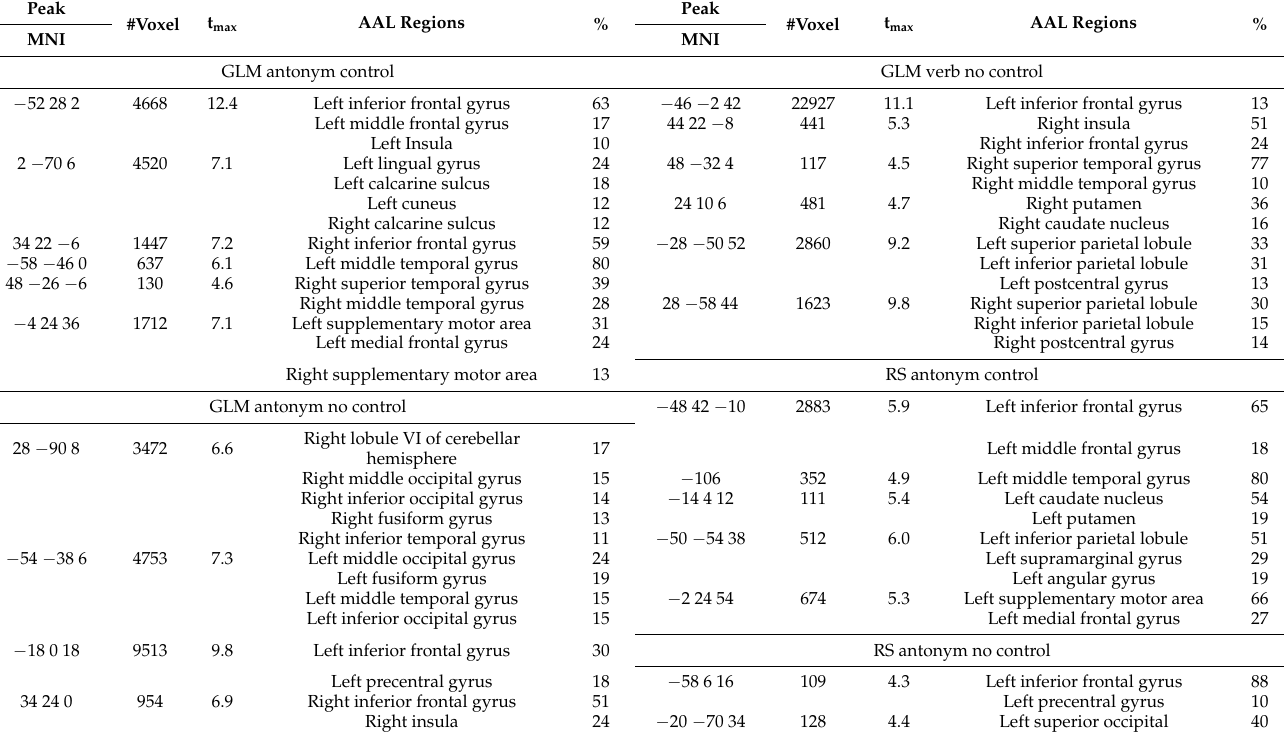
Figure 2. Antonym generation: In this figure, the mean images of the used GLM contrast images and selected ICs for the antonym generation task are shown. The first row depicts the GLM result without using the control condition and the second row the corresponding RS-fMRI result. The third row shows the mean of the selected language-related ICs when using the GLM contrast with control condition as template, and the fourth row shows the same for RS-fMRI. Table 2. This table lists the cluster distributions of each group statistics image. The distributions of clusters are described by the peak coordinates (Peak MNI), the number of voxels in each cluster (#Voxel), the maximum t-value (t max ), the AAL (automatic anatomic labeling) regions containing at least 10% of the cluster’s voxels, and the percentage of voxels of the cluster in the particular